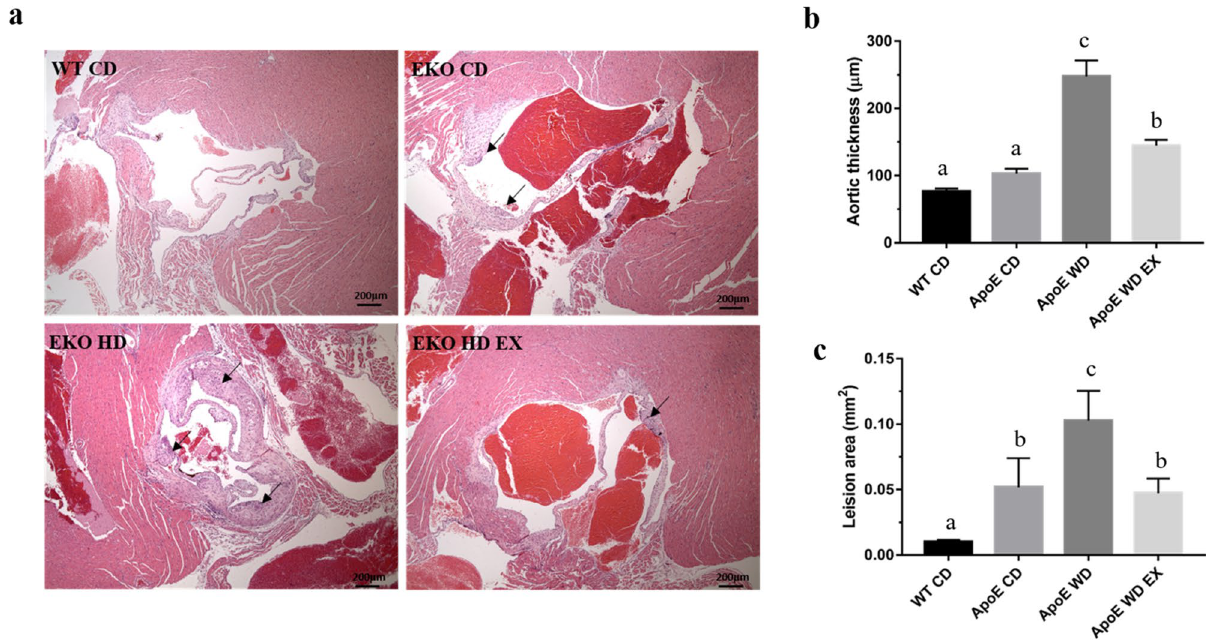
Figure 1. Effects of endurance exercise on atherosclerotic pathogenesis in ApoE knockout mice. ( a ) Representative H&E stain of aortic sinus sections. Arrowhead indicates atheromatous plaques. Scale bar: 200 μm. ( b ) Quantitative analysis of aortic sinus sections to detect aortic thickening and ( c ) atherosclerotic lesions. Values are mean ± SEM ( n = 6). Different superscript letters (a, b, and c) indicate significant differences ( P < 0.05) between groups in one-way